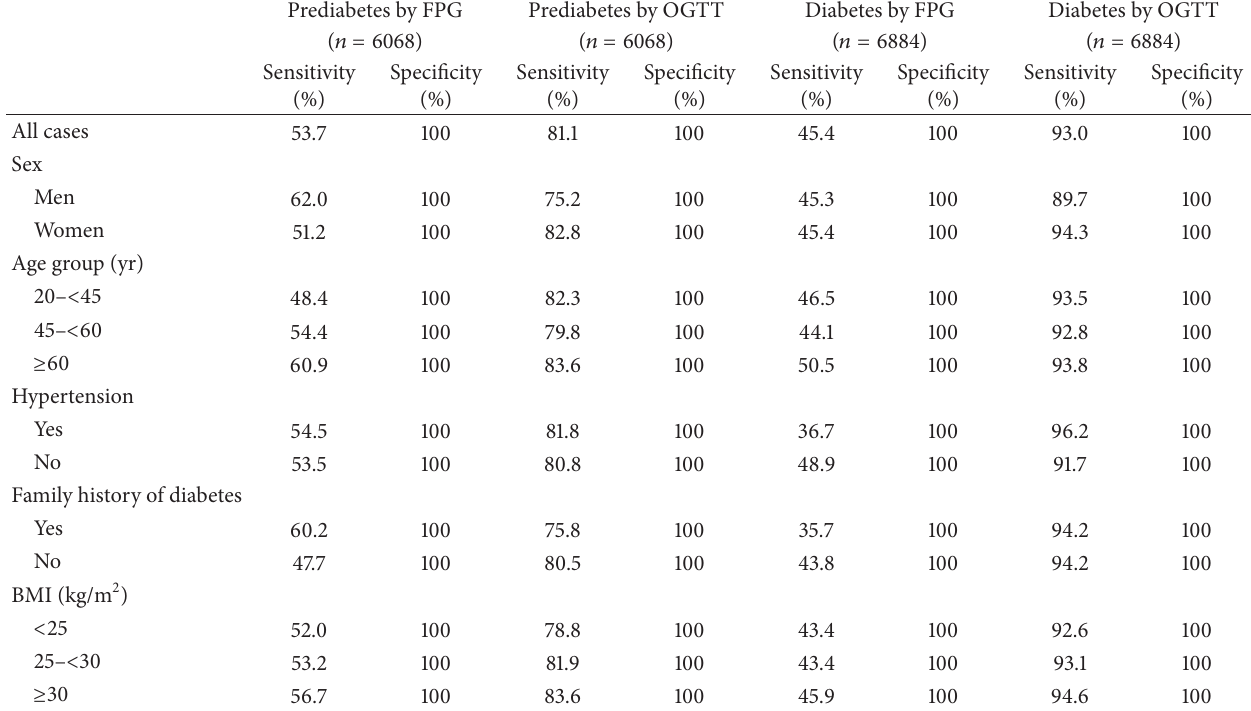
Table 4: Sensitivity and specificity for detecting prediabetes and diabetes by FPG and OGTT stratified by selected factors. Prediabetes by FPG Prediabetes by OGTT Diabetes by FPG Diabetes by OGTT